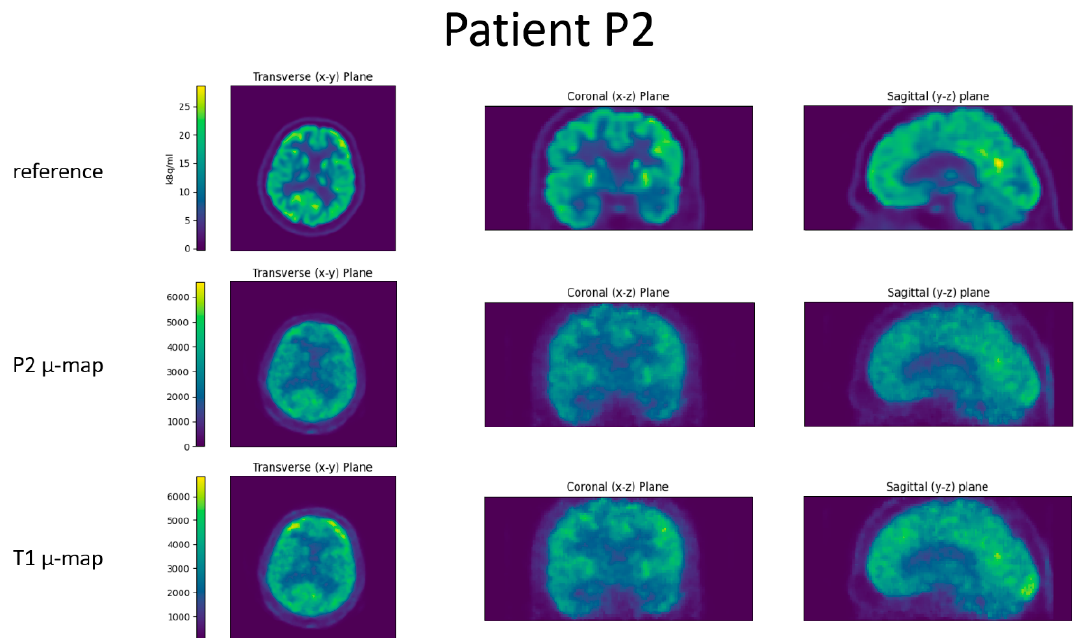
Figure 7. Slices through the reconstructed images for patient P2. Top row is the reference PET scan, middle row the BPET reconstruction using the patient-specific µ-map (from CT of patient P2), bottom row the BPET reconstruction using an independent template µ-map fitted with the method presented in this article.